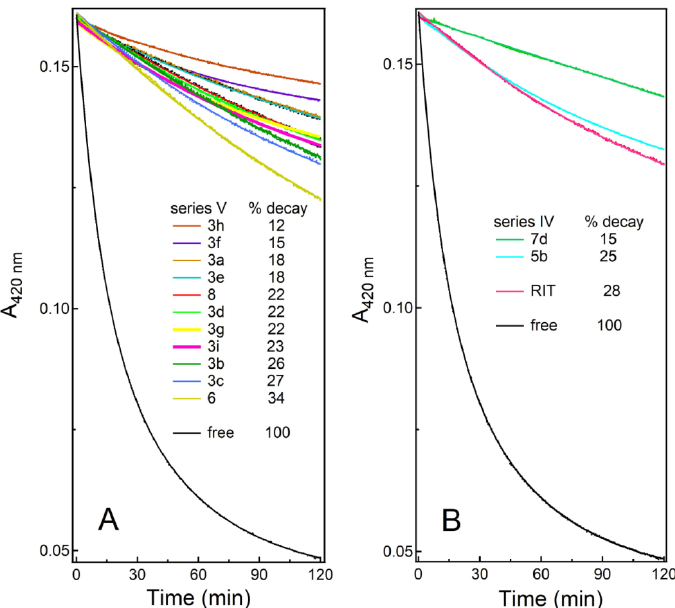
Figure 8. H 2 O 2 -dependent heme depletion in ligand-free and inhibitor-bound CYP3A4. ( A ) Effect of series V inhibitors on the heme accessibility to H 2 O 2 . Overall, the inhibitor binding significantly protected the cofactor, and the amount of heme destroyed correlated with the K s /IC 50 values. ( B ) A comparative assay for CYP3A4 bound to ritonavir and the best series IV inhibitors, 5b and 7d . The heme accessibility was the lowest in CYP3A4 ligated to the high affinity/potency inhibitors, 3h and 7d